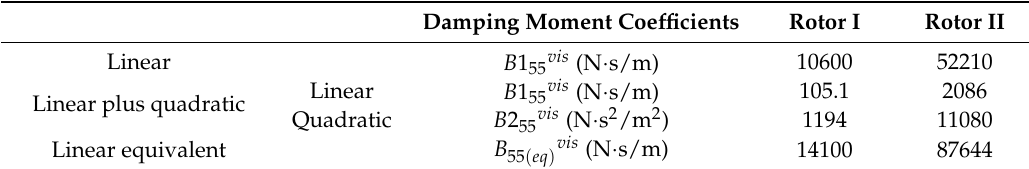
Estimated pitch damping moment coefficients from the free decay tests using the energy